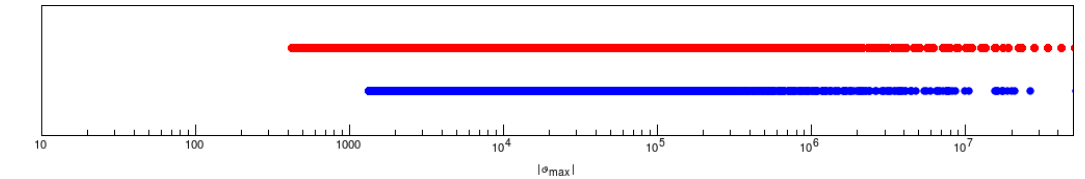
Figure 6 . Distribution of the largest eigenvalue # of the stability matrix of the (cid:12)xed points max of the SU(3) adjoint representation. Blue: eigenvalues for the Y -independent solutions. Red: eigenvalues for the Y -dependent solutions. In both cases, there is no gap and the eigenvalues start at very large